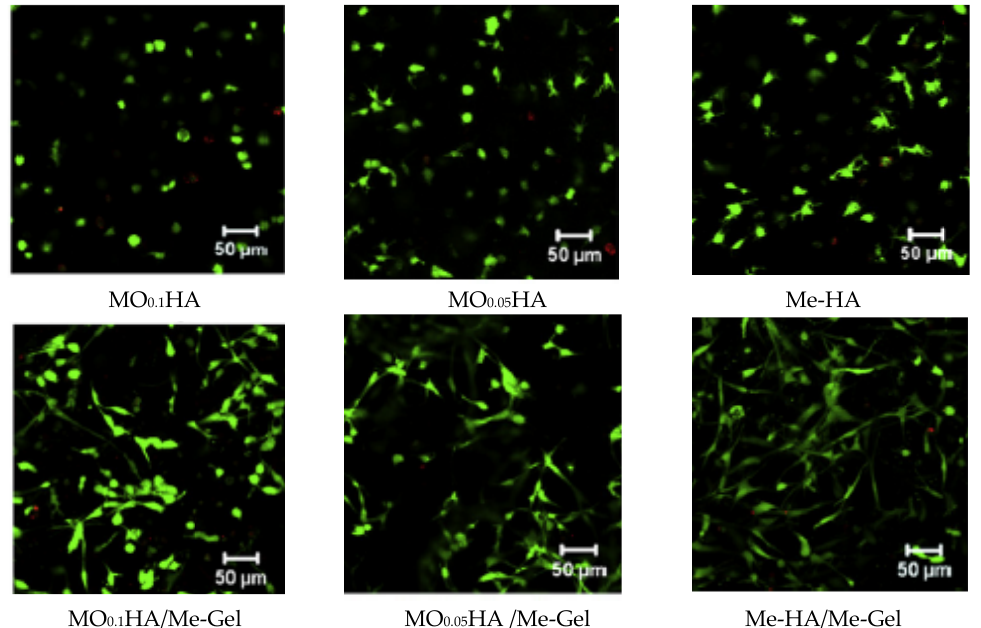
Figure 12. Live/dead assay for encapsulated VICs within HA-based hydrogels, with and without addition of Me-Gel (after 14 days). Adapted with permission from ref. [175]. Copyright 2013, Elsevier.